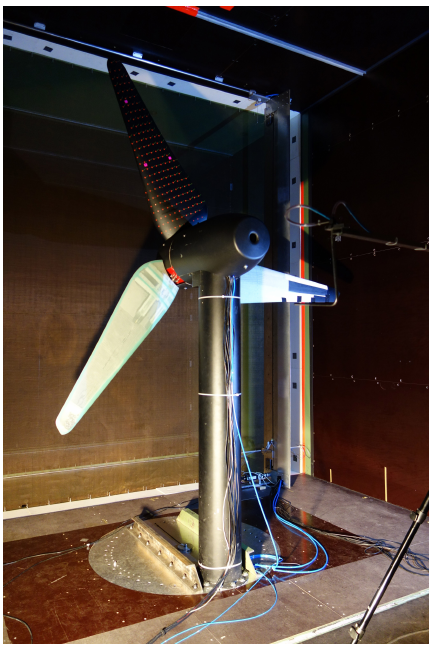
Figure 3. The model wind turbine BeRT in the wind tunnel.